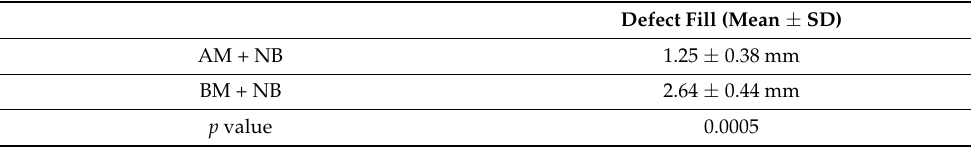
Table 3. Defect Fill (Mean [mm] ± SD) at baseline, 3 months and 6 months ( n = 10 patients in each